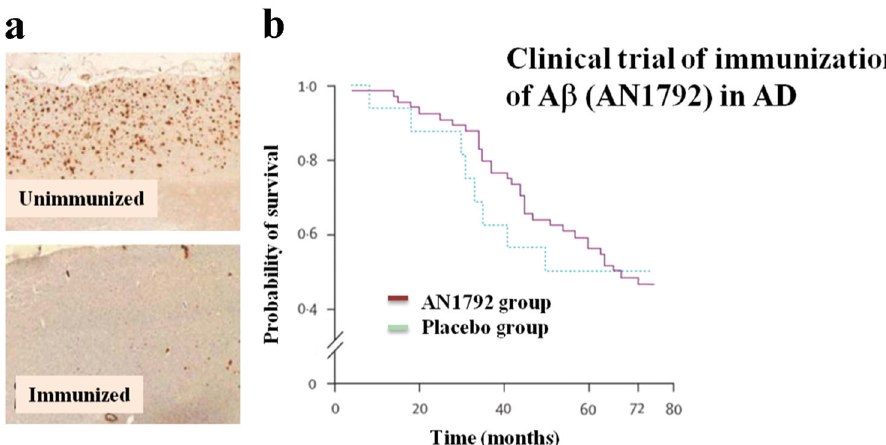
Fig. 1 Clinical trial of A β immunotherapy for AD. a Representative fi gures of the A β immunohistochemistry of the AD autopsy brains with ( low ) or without ( upper ) immunization of A β (AN1792). b In contrast to histology, there were no signi fi cant differences in cognitive functions between AN1792-treated- and placebo treated-groups. Reprinted from Holmes et al. (2008) 7